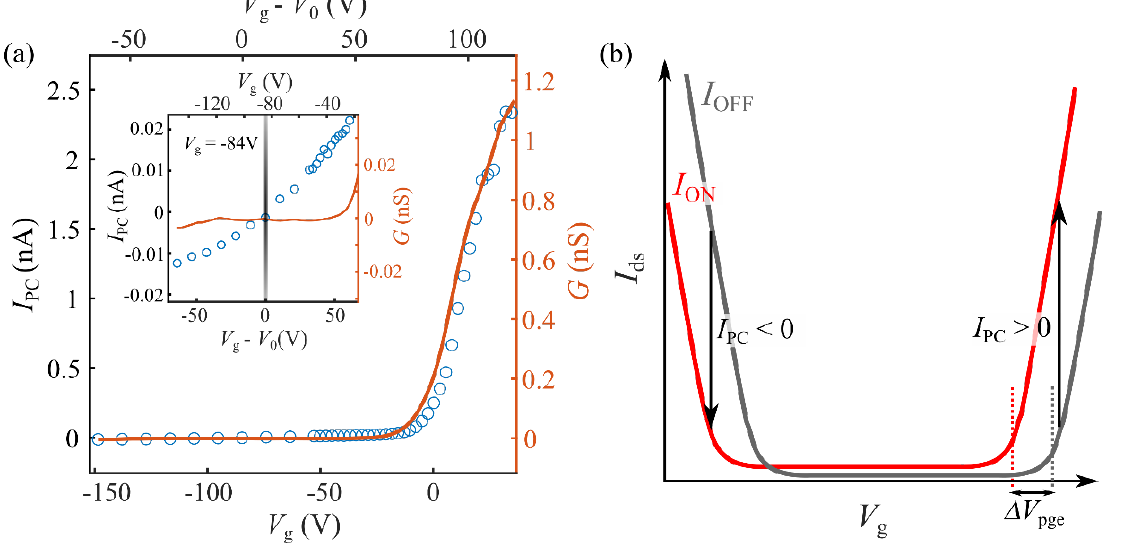
Figure 4. Gate dependence of the observed photocurrent: ( a ) Transconductance of the device (orange line, right axis) and gate-dependent photocurrent measured at V ds = 10 V, in resonance with the exciton X A transition, at a modulation frequency of f = 31.81 Hz. The inset shows a zoomed-in view of the region where the channel is closed. ( b ) Schematic gate ramps of an ambipolar transistor, under illumination and no illumination. The photoresponse contribution of ∆ V pge is depicted in the plot.